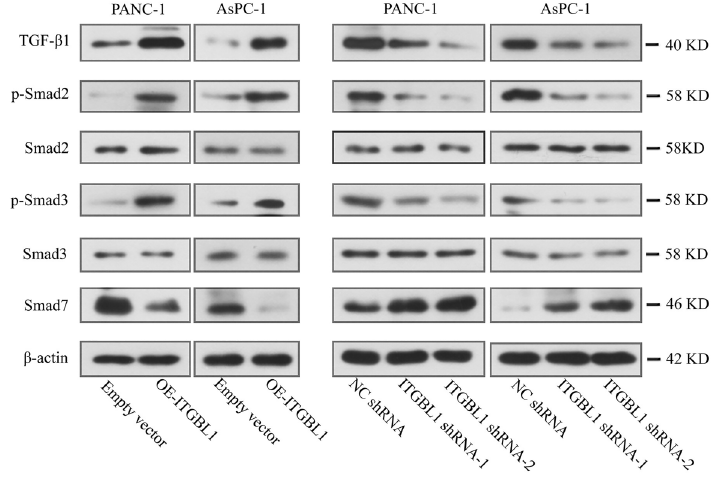
Figure 5. ITGBL1 activated the TGF- b /Smad pathway in pancreatic cancer cells. The protein expression levels of TGF - b 1, Smad2, p-Smad2 (S465/S467), Smad3, p-Smad3 (S423/S425), and Smad7 in pancreatic cancer cells with ITGBL1 upregulation (OE-ITGBL1) or downregulation were detected by western blot. N=3. NC: negative